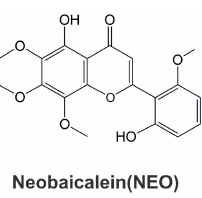
Figure 1. Chemical structural of Neobaicalein (NEO).